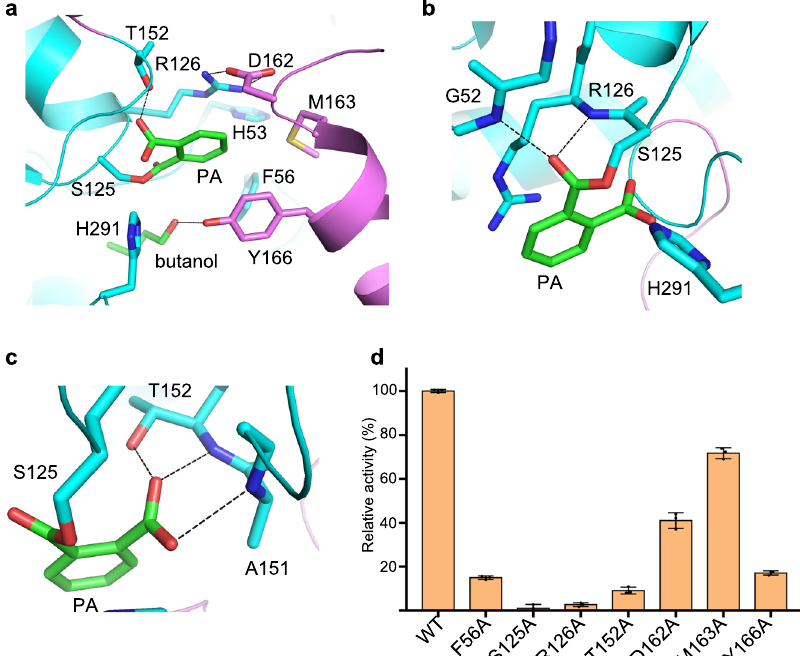
Fig. 3 The substrate binding pocket of MehpH. a Residues involved in the active site of MehpH. The hydrogen bonds formed between the residues and the substrate are shown as black-colored lines. b The oxyanion hole in the active site. c The interactions between MehpH and the free carboxyl group on PA. d Hydrolytic activities of MehpH and its variants using MBP as substrate. The experiments were carried out using MBP concentration of 1.0 mM and enzyme concentration of 1.0 µ M. The amount of MBP and produced PA was monitored by HPLC at a wavelength of 254 nm. The activity of wild type (WT) MehpH was set as 100%, and the hydrolytic activities of the variants were compared to that of the WT. Error bars represent the s.d. values obtained in triplicate